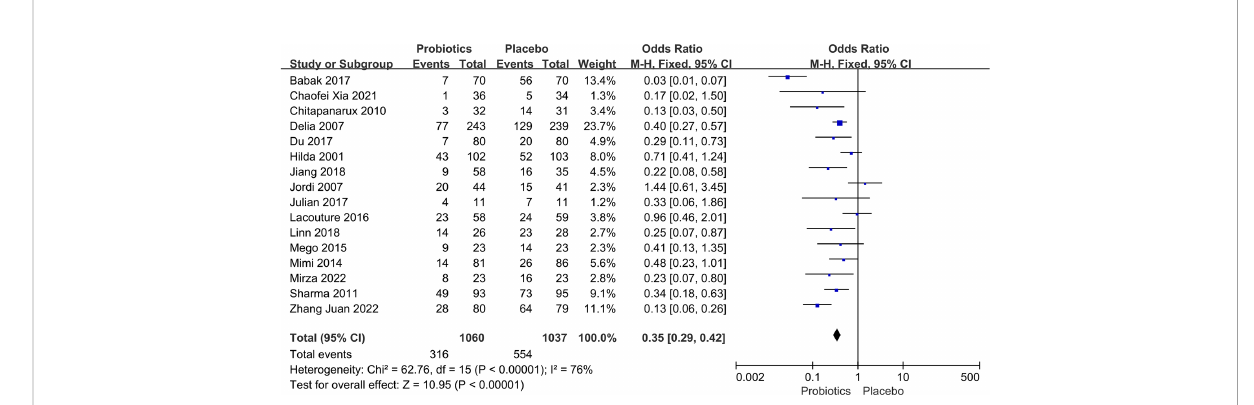
FIGURE 3 Forest plot of incidence of side effects in probiotic and placebo groups after radiotherapy or chemotherapy for different cancers.